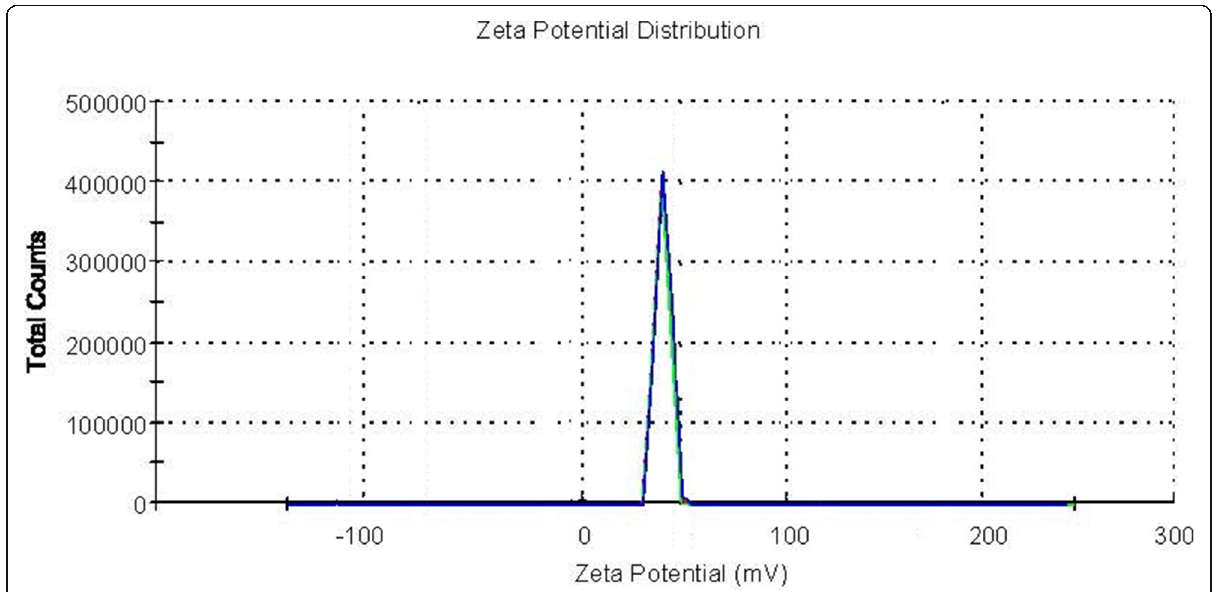
Fig. 4 Zeta potential of optimized